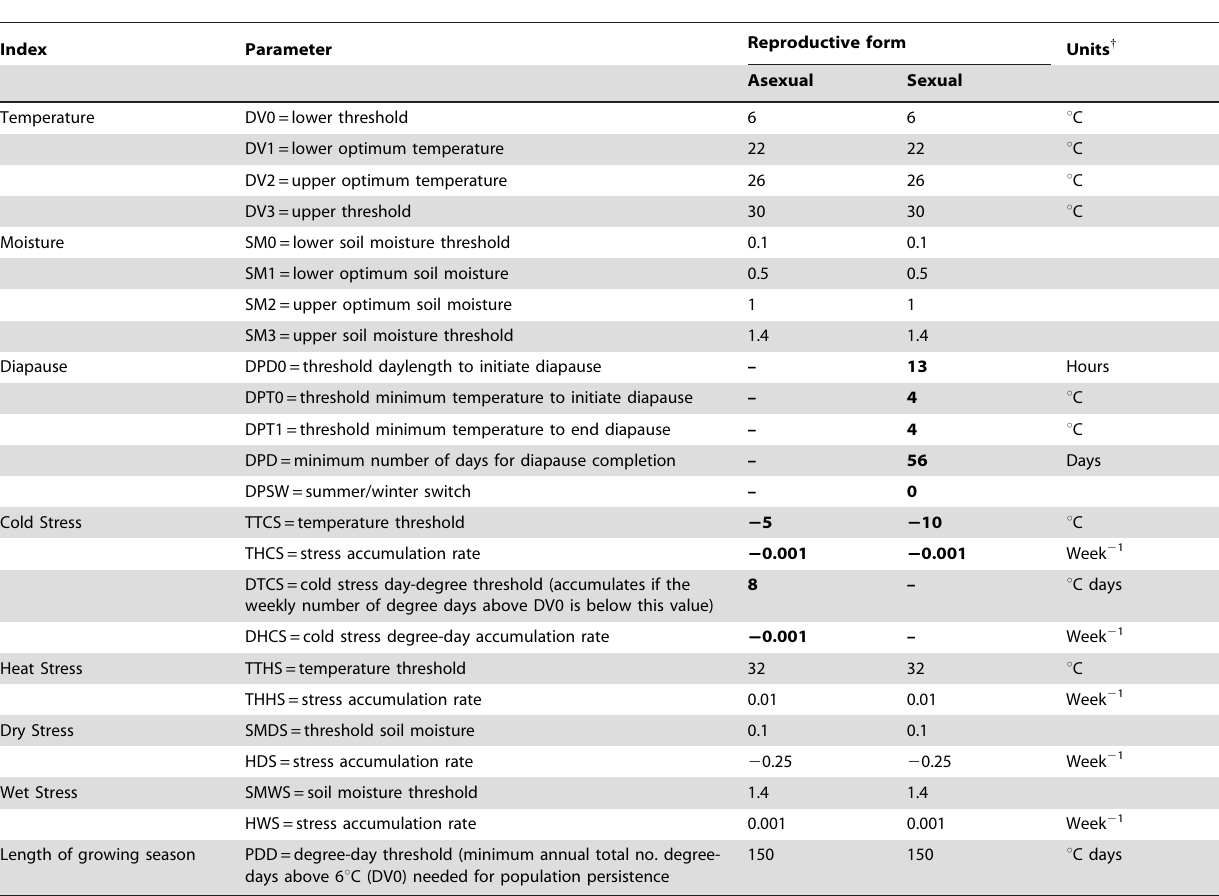
Table 1. CLIMEX parameters for asexual and sexual reproductive forms of Rhopalosiphum padi